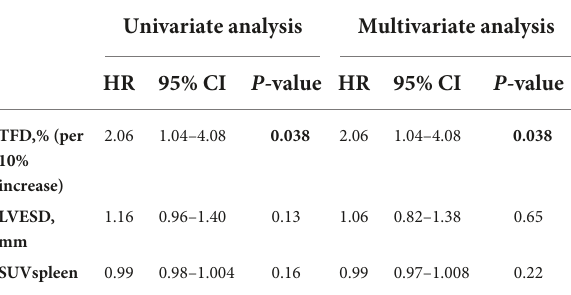
TABLE 6 Cox regression analysis for MACE in patients with cardiogenic